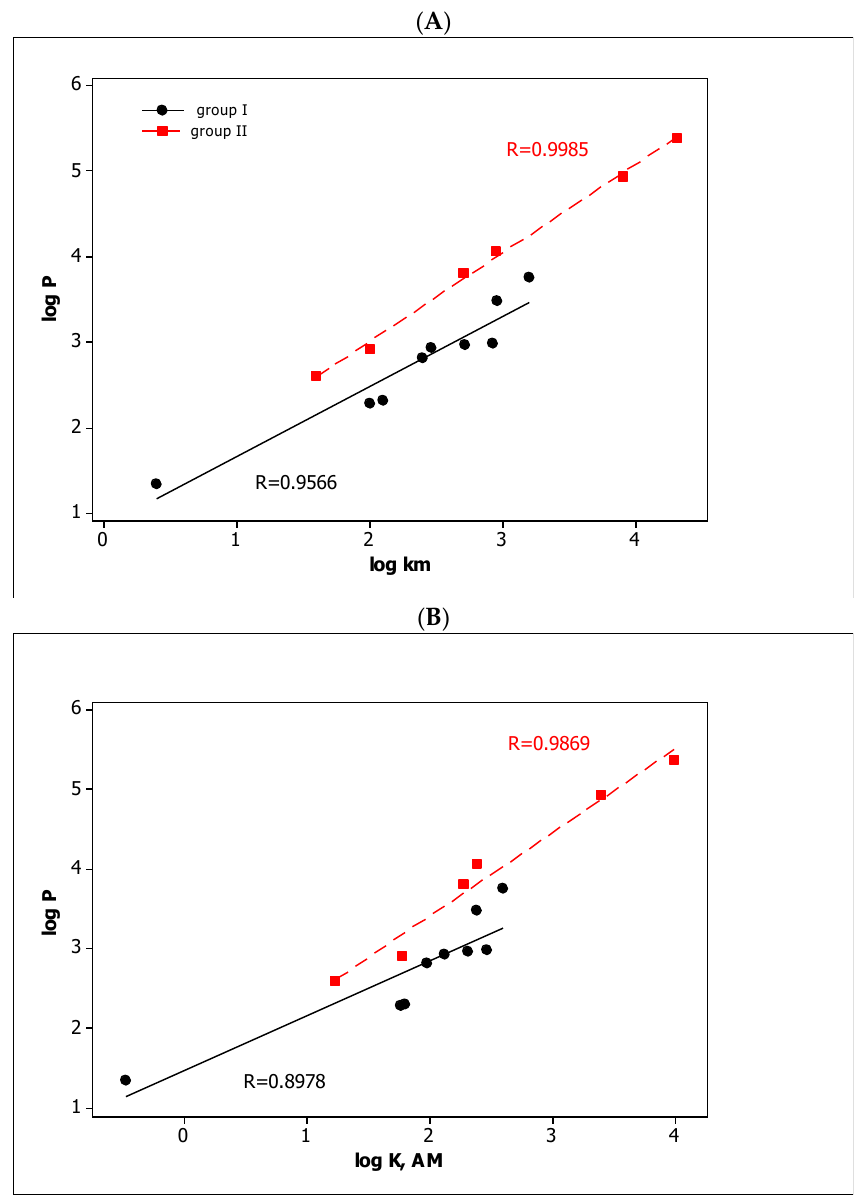
Figure 1. The log P vs. log k m ( A ) and log P vs. log K AM ( B ) relationships obtained for tested com- pounds.